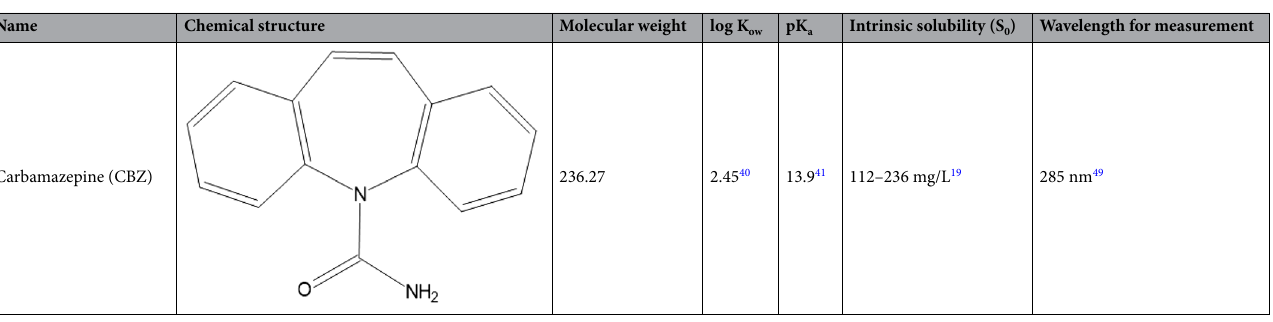
Table 1. Characteristics of